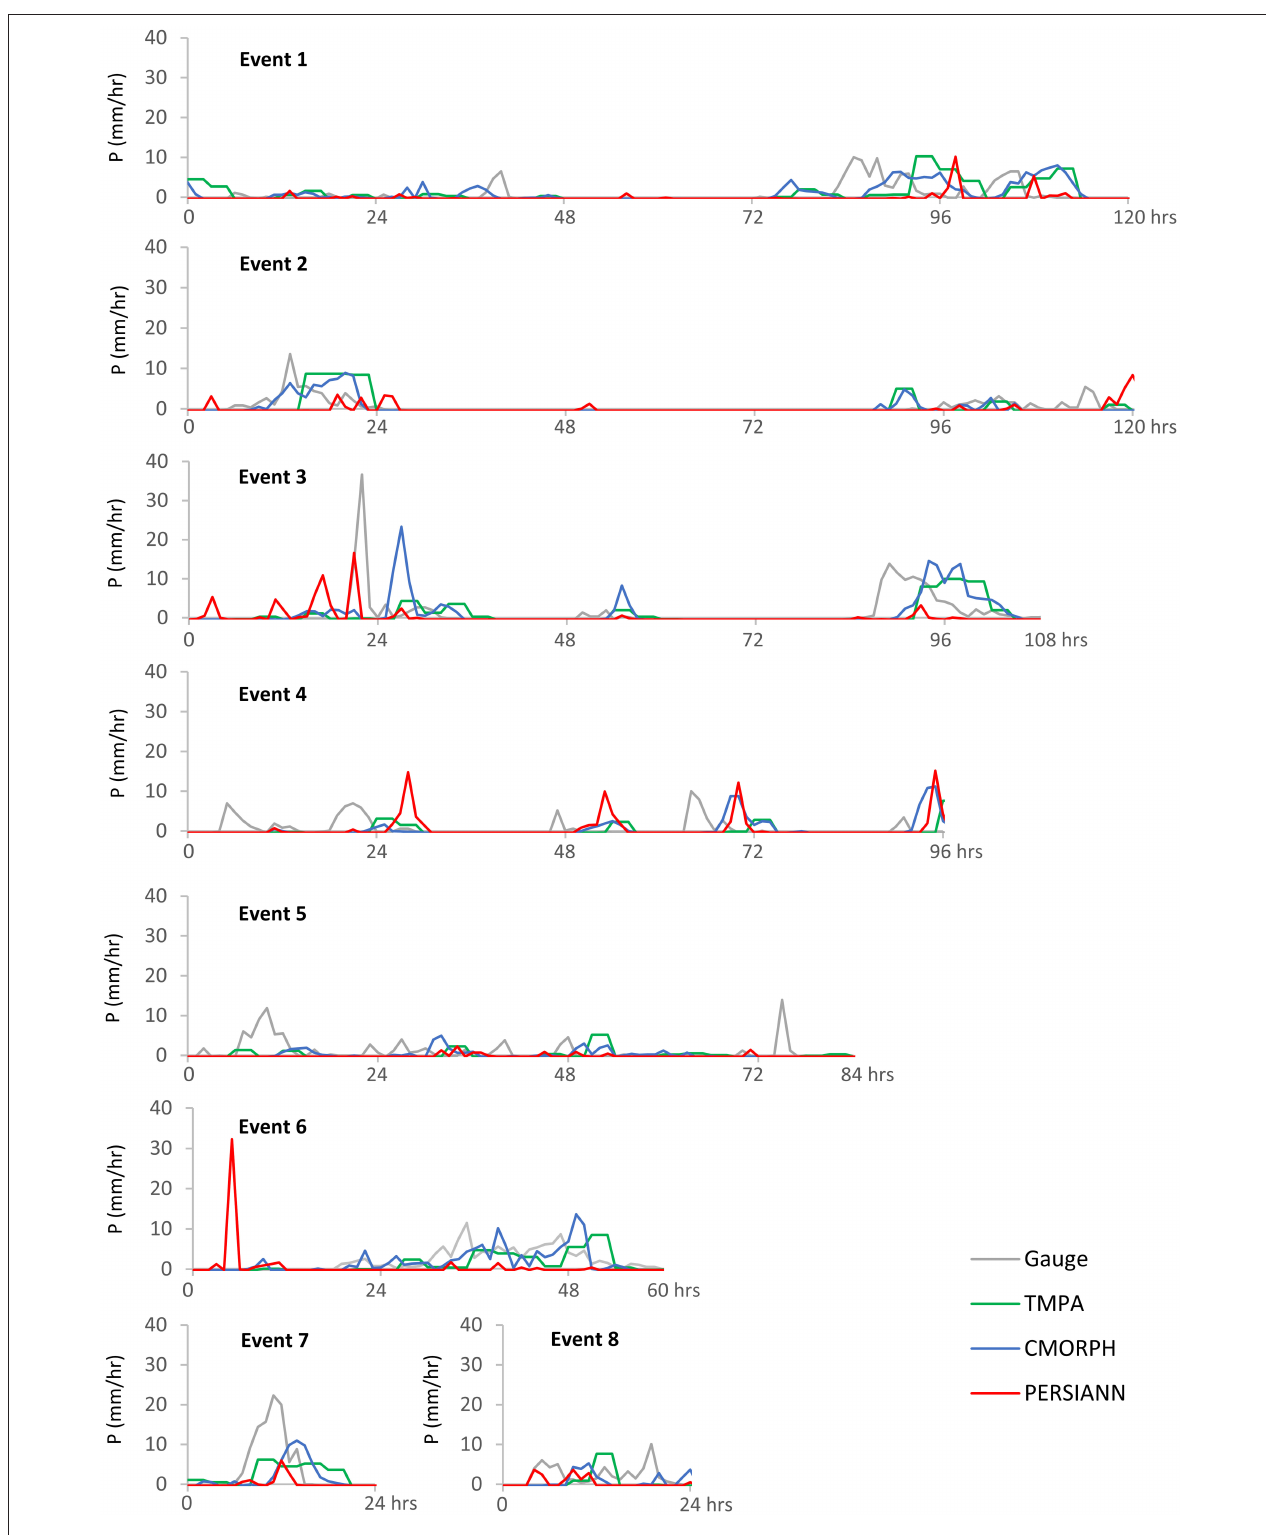
FIGURE 6 | Precipitation time series plots of hourly intensity (mm/h) recorded at rain gauge EVGR, and by TMPA, CMORPH, and PERSIANN at gauge location EVGR during the eight hydrometeorological extreme events.